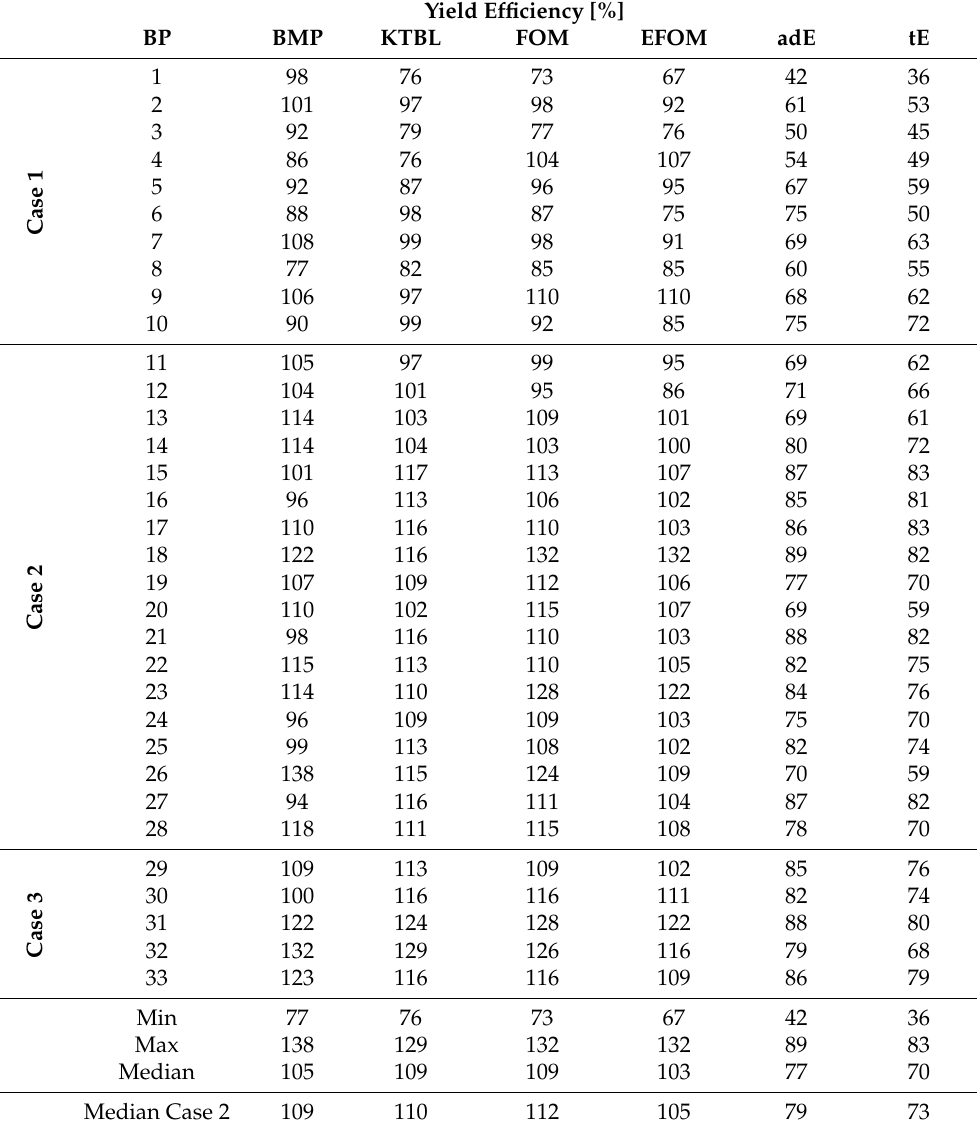
Table 2. Yield efficiency (YE) of 33 biogas plants (BP) determined by literature values of Association for Technology and Structures in Agriculture (KTBL), biochemical methane potential test (BMP), fermentable organic matter (FOM), energy fermentable organic matter (EFOM), anaerobically degrad- able energy (adE) and total energy (tE). The minimum (Min), maximum (Max) and median values were calculated for each parameter. The median of BP fitting Case 2 were also calculated. BP 12 is a research biogas plant with high measurement